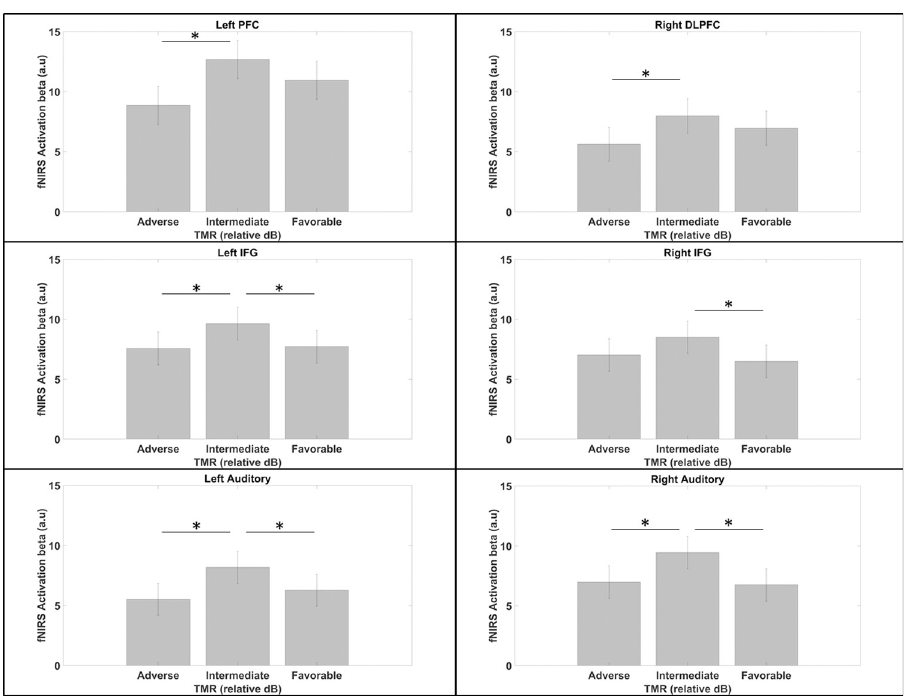
Fig 4. HbO activations for the TMR condition effect (t-test results). � : p < 0.05 (FDR-corrected) for the number of ROI areas. Vertical bars denote the standard error of the mean.